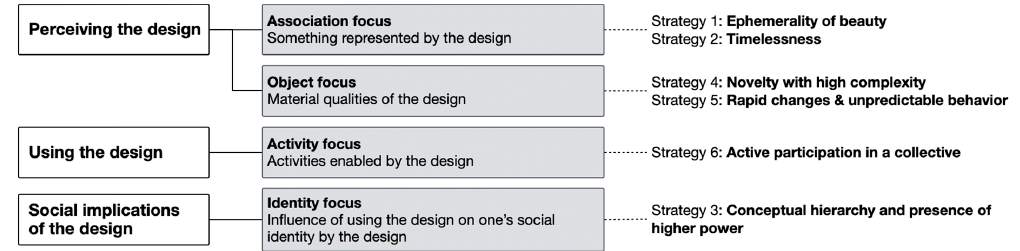
Figure 2. Overview of design strategies within their respective emotion source categories.